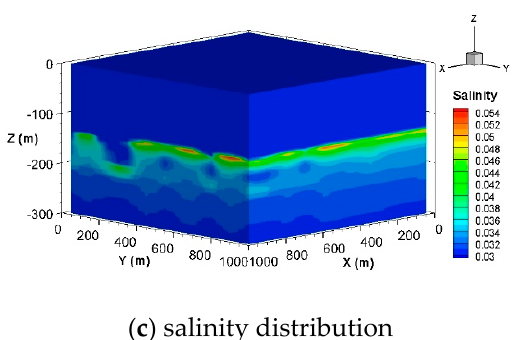
Figure 7. Gas, hydrate and salinity distribution at a simulated time of 1000 years (gas injection from the whole bottom surface).